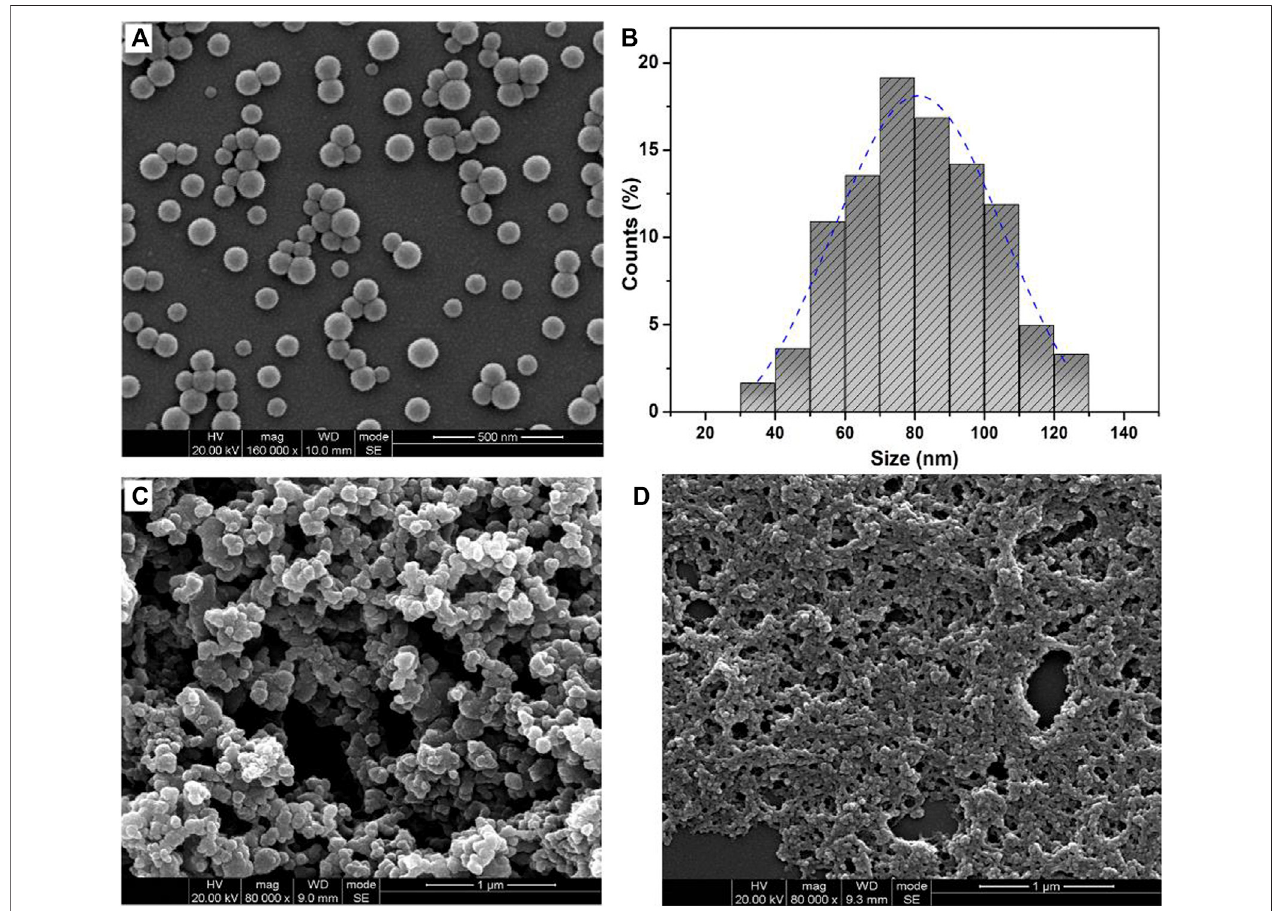
FIGURE 5 | The SEM morphology (A) and corresponding size distribution histogram (B) of polymeric nanoparticles obtained via the solvent exchange – induced self-assembly of pristine PAE-NC, and the morphology of Zn 2+ (C) and Cu 2+ (D) cross-linked PAE-NC self-assembled nanostructures.